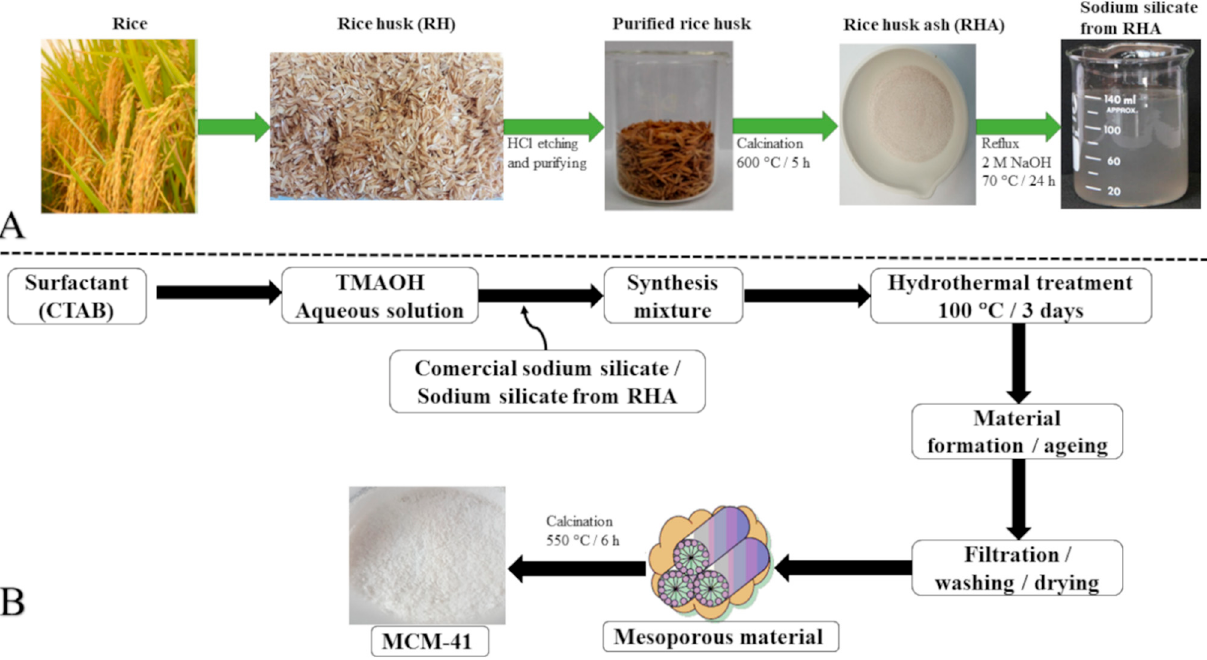
Figure 3. ( A ) Flow chart showing RHA obtainment from rice. ( B ) Comprehensive scheme of the MCM-41 synthesis from commercial sodium silicate or RHA-extracted sodium silicate.